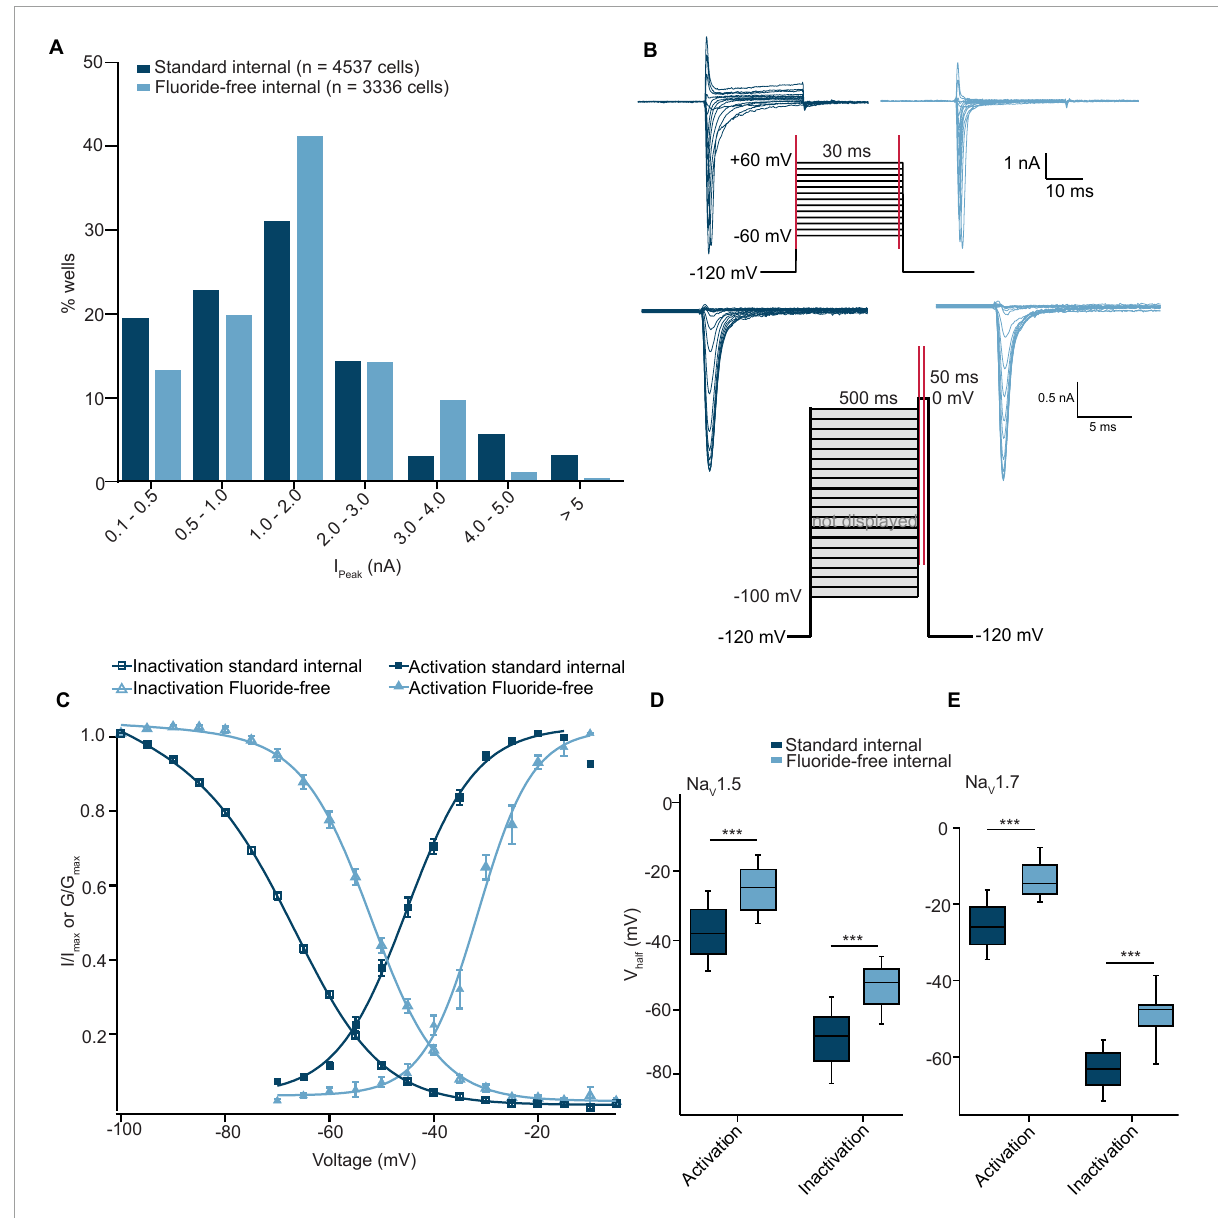
FIGURE4 Na V 1.5 recorded in standard and fluoride-free internal solution. (A) Histogram plot of I Peak values recorded using standard internal and fluoride-free internal solution. (B) Current-voltage traces of Na V 1.5 expressed in CHO cells using an activation protocol (top) and inactivation protocol (bottom) for both conditions. (C) Activation (fit with an extended Boltzmann equation, see Section “Data analysis”) and inactivation IV curves (fit with a Boltzmann equation, see Section “Data analysis”) for Na V 1.5 in standard internal and fluoride-free solution are shown overlaid. (D) The V half values of activation of 484 cells in standard internal were significantly more negative compared with 241 cells in fluoride-free internal. The same shift to more negative V half of inactivation was also found for 728 in standard internal fluoride compared with 165 cells in fluoride-free internal (Student’s t -test, *** P < 0.001). (E) A shift in the V half values of activation and inactivation was also observed for Na V 1.7 where V half values for activation of 433 cells in standard internal were significantly more negative compared with 29 cells in fluoride-free internal and the V half of inactivation for 493 in standard internal fluoride were significantly more negative compared with 14 cells recorded in fluoride-free internal solution (Student’s t -test, *** P <